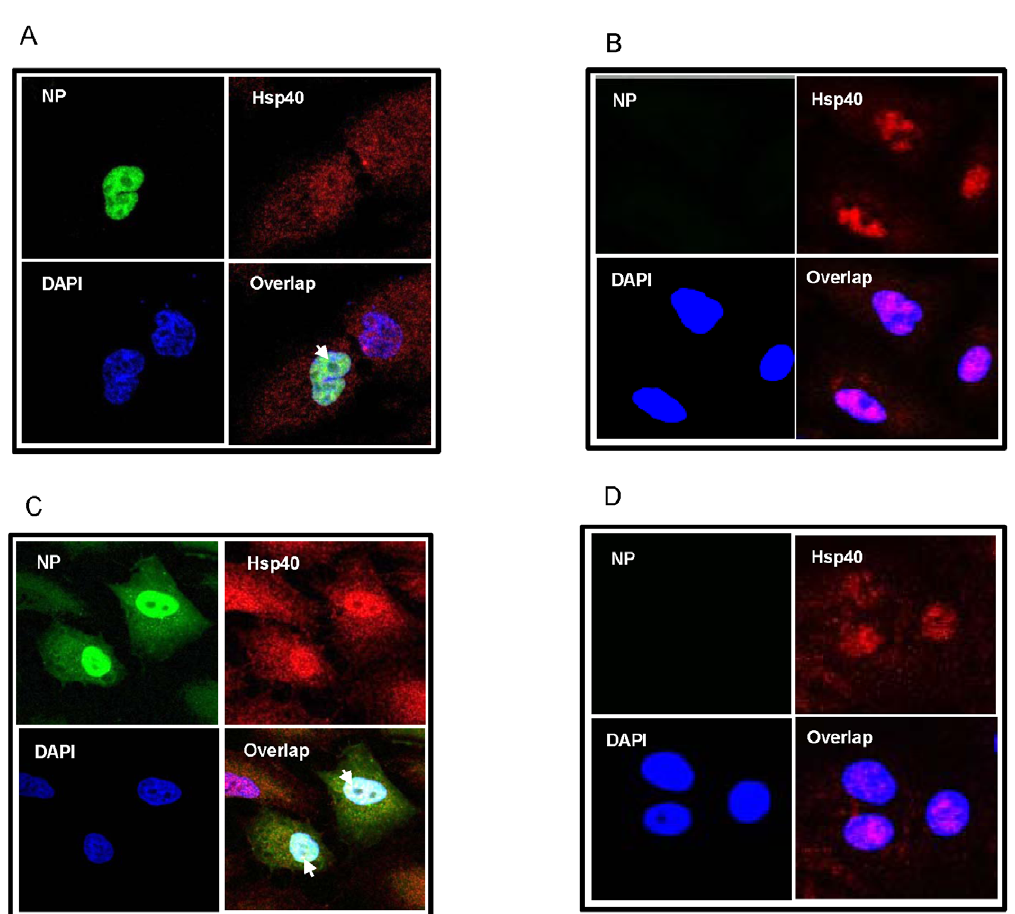
Figure 3. Co-localization of IAV NP and Hsp40 in nucleus of mammalian cells. AandB. A549 cells were transfected with pcDNA3.1-NP or control pcDNA3.1 plasmid for 24 hours, and cells were fixed and processed for immunostaining. NP was stained using anti-Myc tag specific primary antibody and Alexa488 conjugated secondary antibody (Green). Hsp40 was stained using Hsp40 specific primary antibody and Alexa 594 conjugated secondary antibody (Red). Nuclei were stained with DAPI. A shows pcDNA3.1-NP transfected cells whereas B shows control pcDNA3.1 transfected cells. Panels are labeled for their respective staining. Lower right panel shows nuclear colocalization of NP and Hsp40. C andD. A549 cells were infected with PR8 influenza A virus at 1 MOI for 24 hours, and cells were fixed and processed for immunostaining. NP was stained using anti-NP monoclonal primary antibody and Alexa488 conjugated secondary antibody (Green). Hsp40 was stained using Hsp40 specific primary antibody and Alexa 594 conjugated secondary antibody (Red). Nuclei were stained with DAPI. Panels are labeled for their respective staining. C shows PR8 infected cells whereas D shows control uninfected cells. Lower right panel in C shows primarily nuclear colocalization of NP and Hsp40. doi:10.1371/journal.pone.0020215.g003 PLoS ONE |